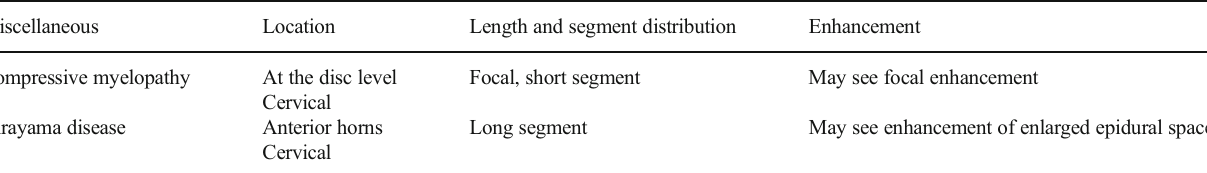
figure formatting, both from the Digital Illustrations division at the University of Rochester, Department of Imaging Sciences.